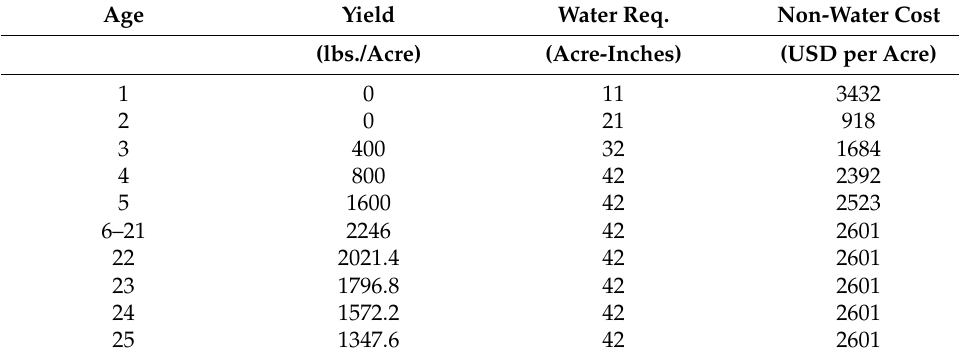
Table 4. Age-dependent parameter values for almonds. Age Yield Water